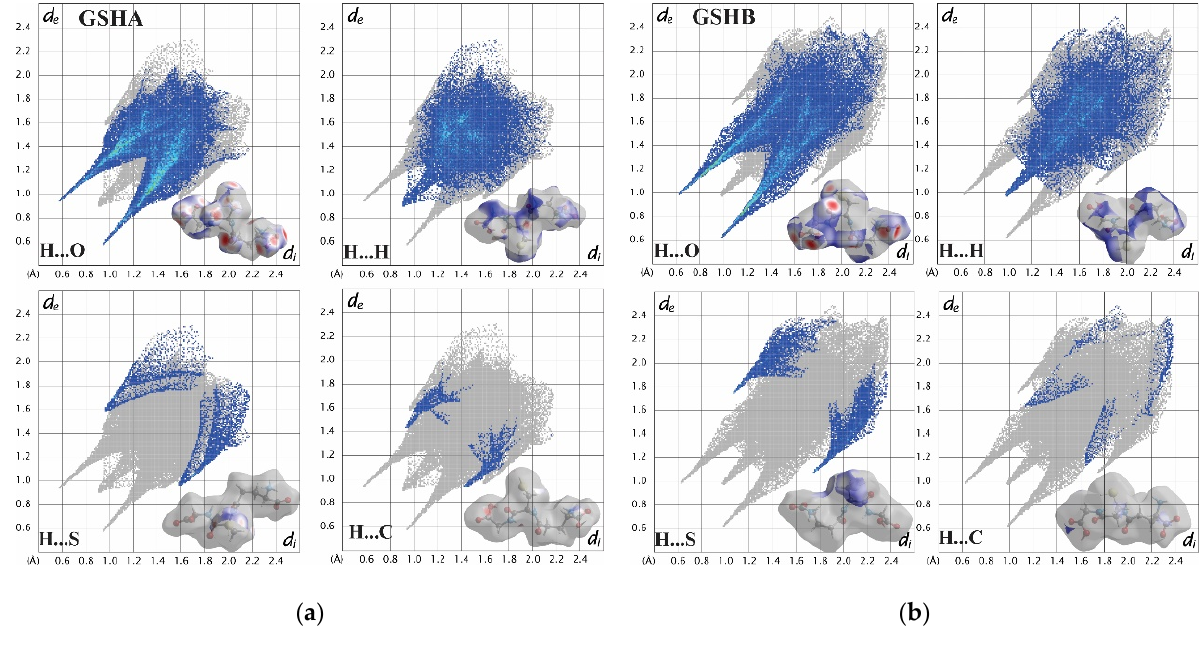
Figure 10. Fingerprint plots for ( a ) GSHA and ( b ) GSHB. Table 4. Hydrogen bond geometry and topological parameters by QTAIM obtained for GSHA and GSHB glutathione molecular